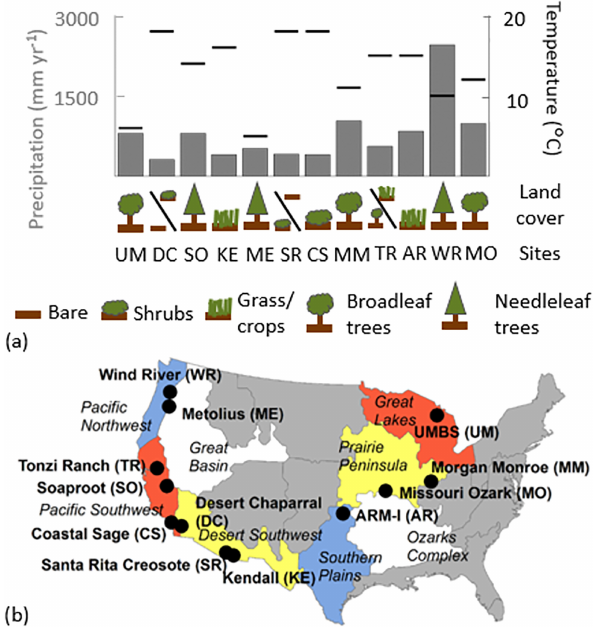
Figure 1. (a) shows the yearly mean precipitation, air temperature, and dominant land cover types for the 12 AmeriFlux/COSMOS sites used. At sites DC, SR, and TR two different land cover types were shown because they covered similar areas in size. The map below (b) shows the locations of the 12 sites within 8 NEON Eco- climatic domains. Data sources: COSMOS, ORNL-DAAC (2015), Goulden et al. (2012), Anderson and Goulden (2012), Scott et al. (2008), Chen et al.